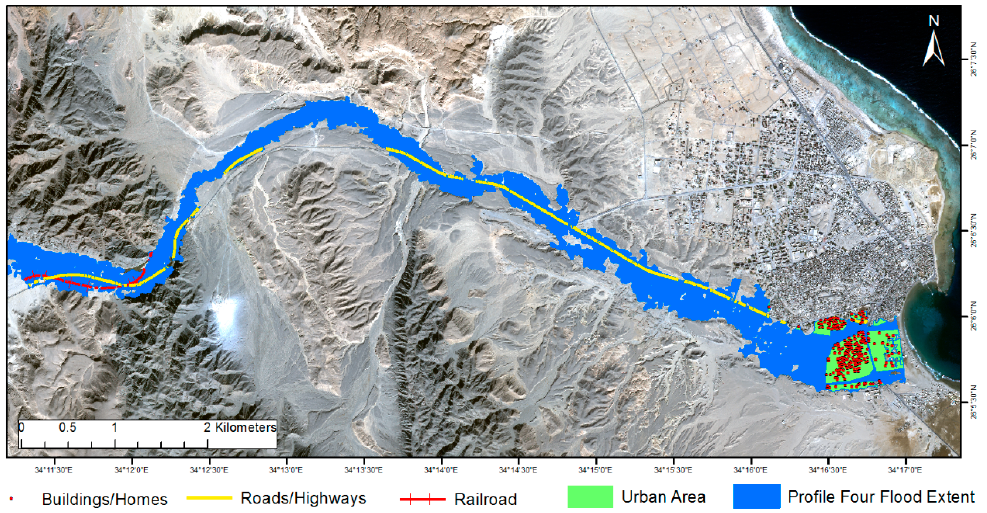
Figure 11. Flood inundation simulation with a rainfall intensity of 60 mm. This flood would surge the southern areas of the town of Quseir with a flood depth of 2 m, inundating 217 buildings, segments of the Qift–Quseir highway, and the phosphate railroad.